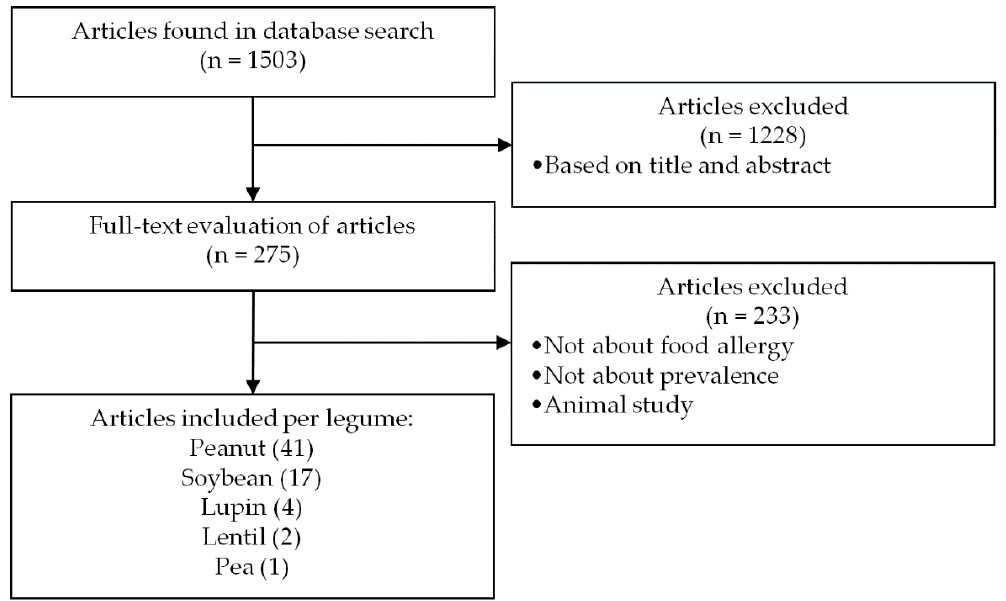
Figure 1. Flow diagram of the literature search approach.